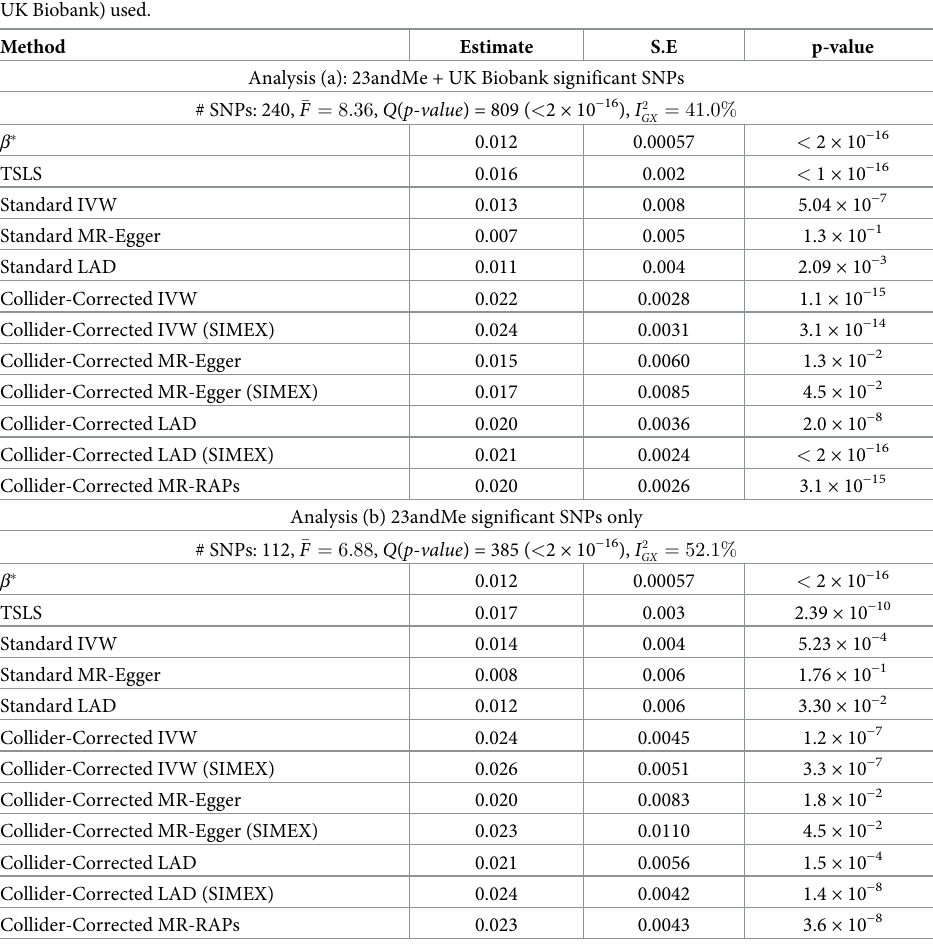
Table 1. Point estimates, standard errors and p-values for the: TSLS, IVW, MR-Egger, LAD-regression and MR-RAPS methods. Estimates reflect the average causal effect of a unit increase in the log-odds of insomnia on HbA1c levels across the population. ‘Standard’ = standard 1-sample analysis. Top rows: Analysis (a)—All 240 SNPs from Jansen et al used. Bottom rows: Analysis (b)—only genome wide significant SNPs from 23andMe data (ignoring UK Biobank)